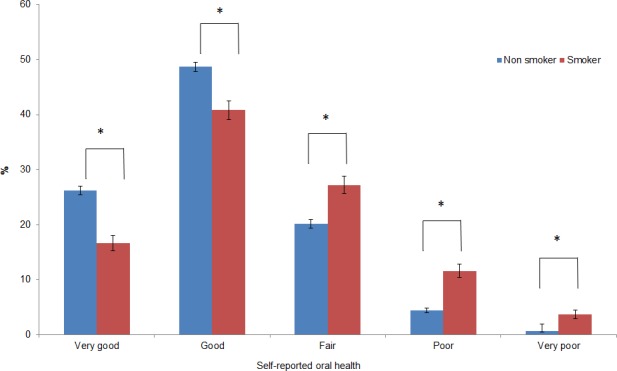
Self-reported oral health status by smoking status (percentage).(error bars indicated 95% confidence intervals) *Significance level 0.05 after Bonferroni correction.